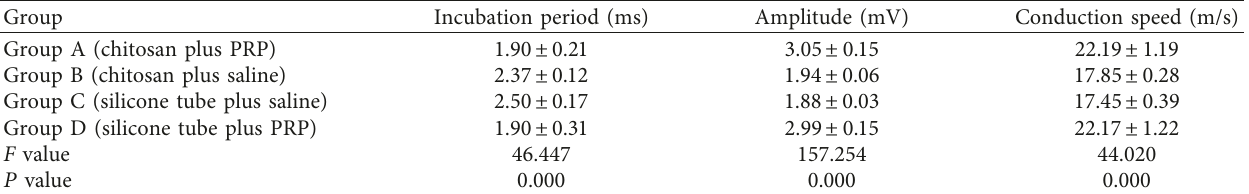
Table 3: Comparison of the latency, amplitude, and conduction velocity of nerve regeneration in each group at 8 weeks after the operation. Group